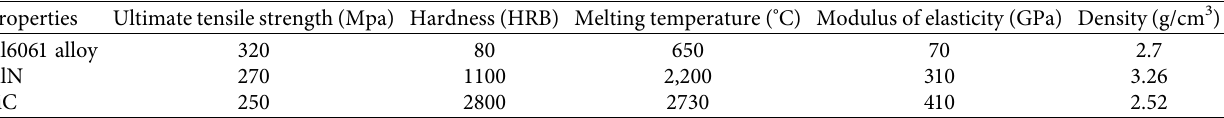
Table 2: Mechanical properties of the matrix (Al6061 alloy) and reinforcements (AlN & SiC) [3, 10, 20].